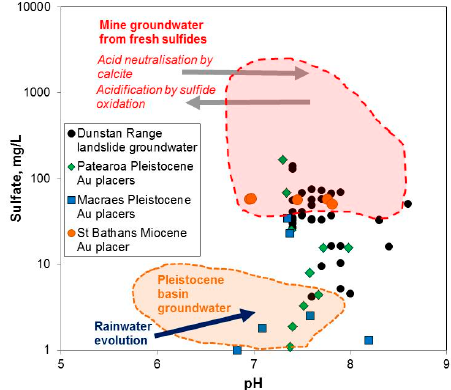
Figure 4. Groundwater pH and dissolved sulfate concentrations for gold placer deposits (Table 1) and associated sediments, landslides, and basement rocks.